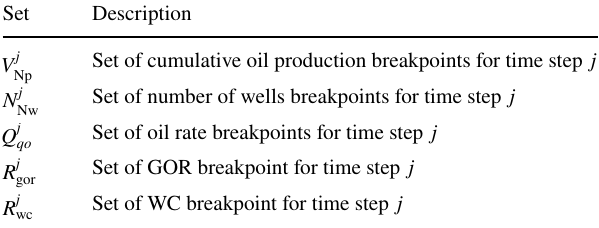
Table 10 Set of breakpoints used in the MILP formulation